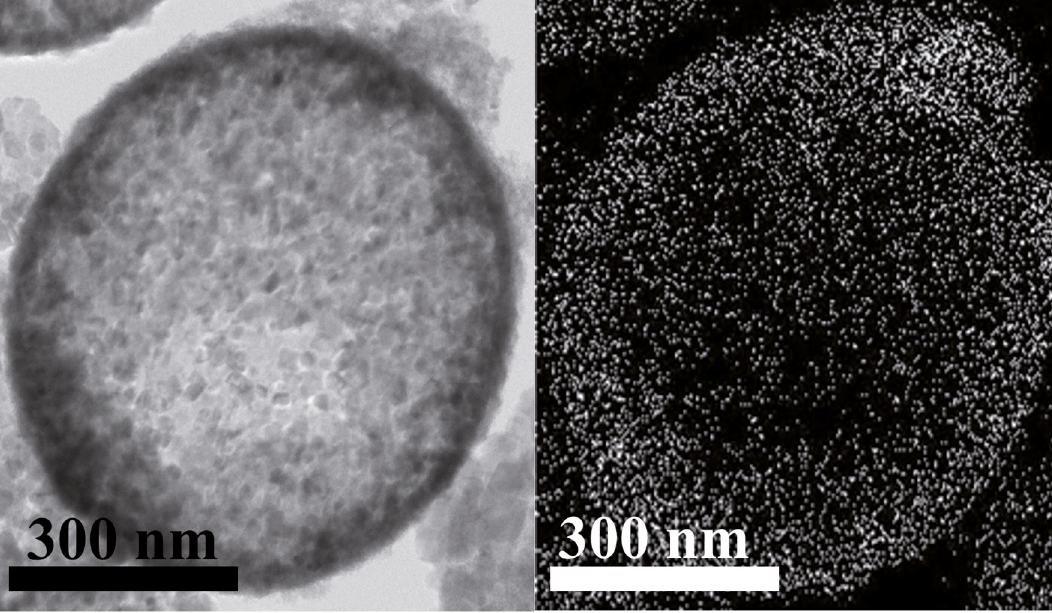
Figure 2: HRTEM image from a single MNP and Elemental mapping of a single MNPs. The scattered white dots indicate the distribution of the As ions on the